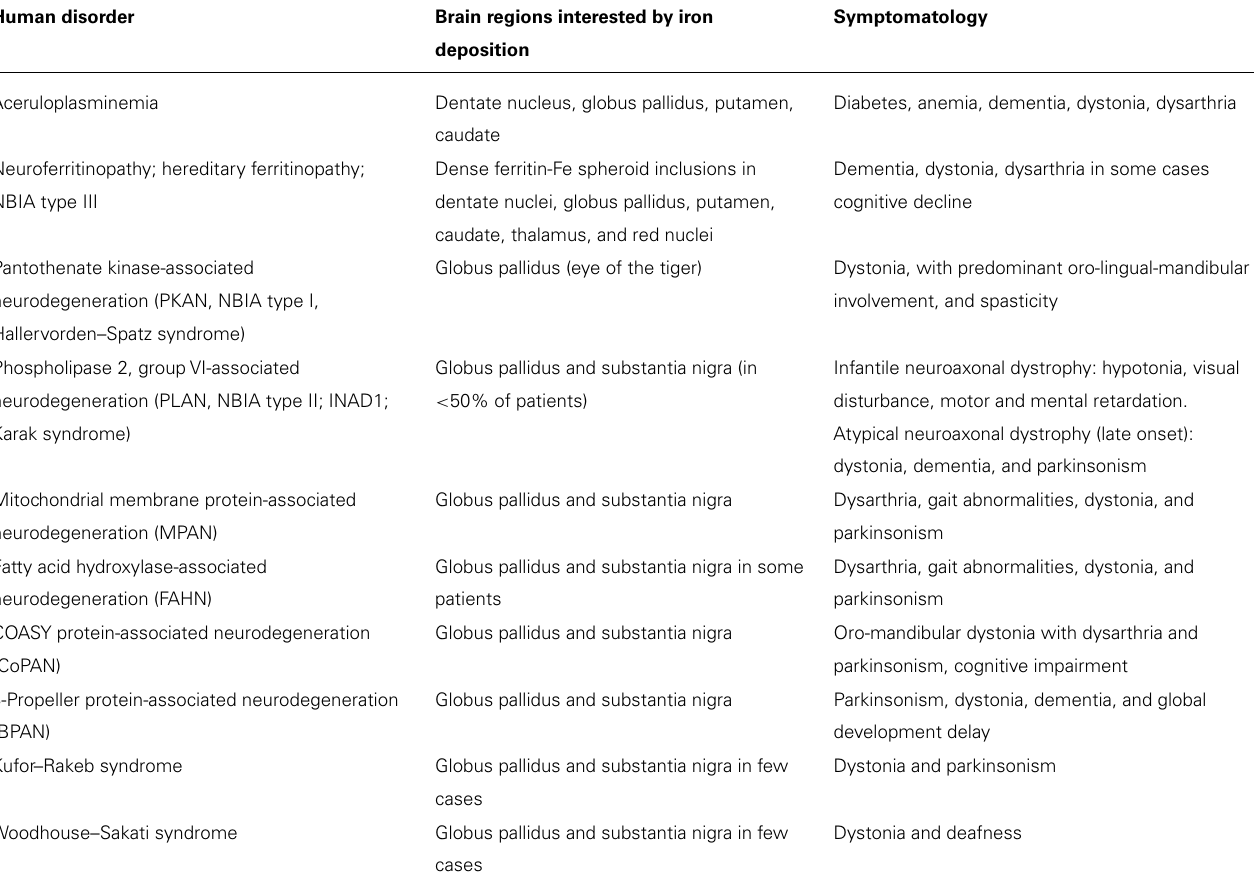
Table 1 | List of the neurodegeneration with brain iron accumulation